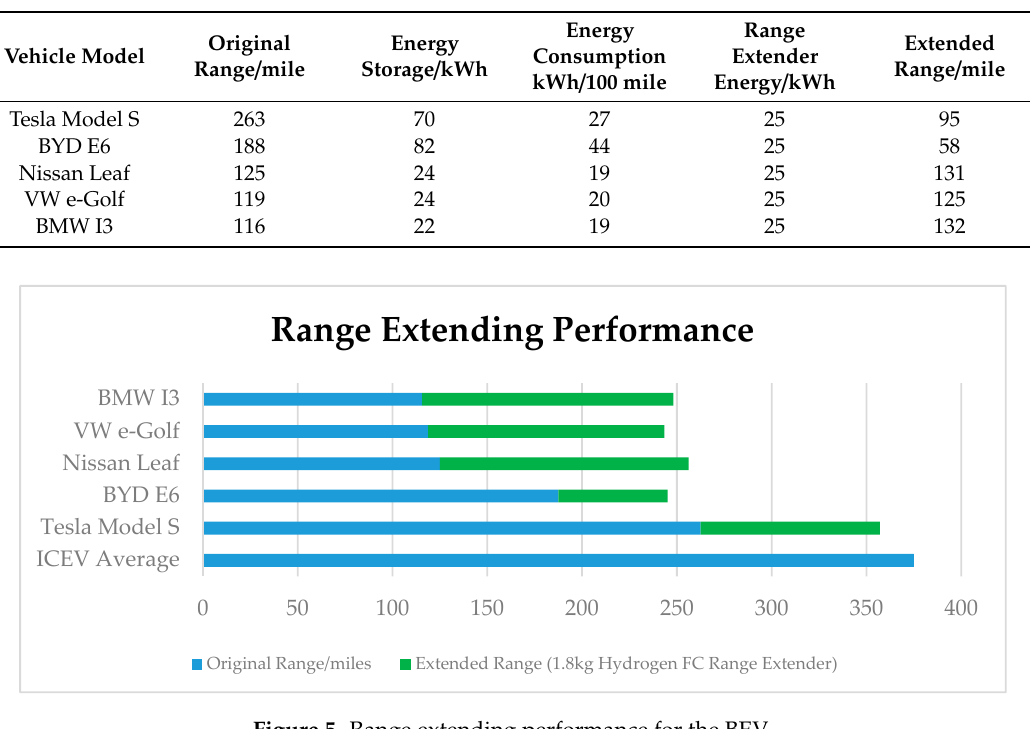
Table 8. Specifications of current BEVs [3].